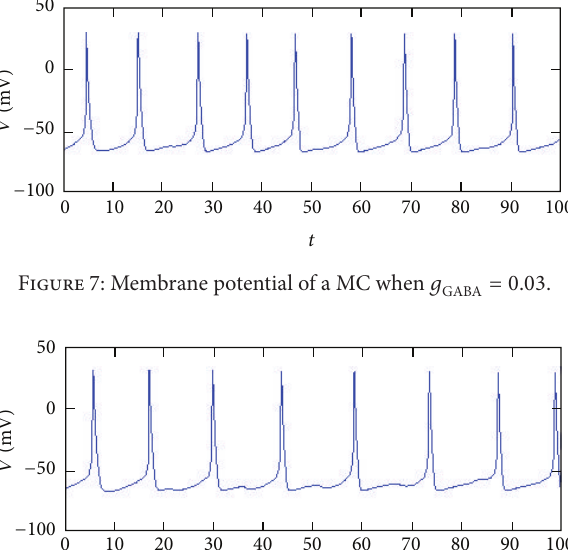
Figure 8: Membrane potential of a MC when 𝑔